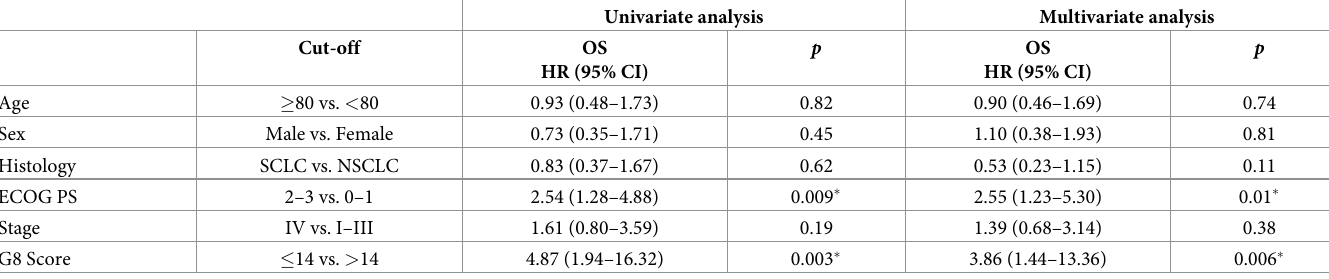
Table 5. Univariate and multivariate survival analyses in patients who received chemotherapy (n =